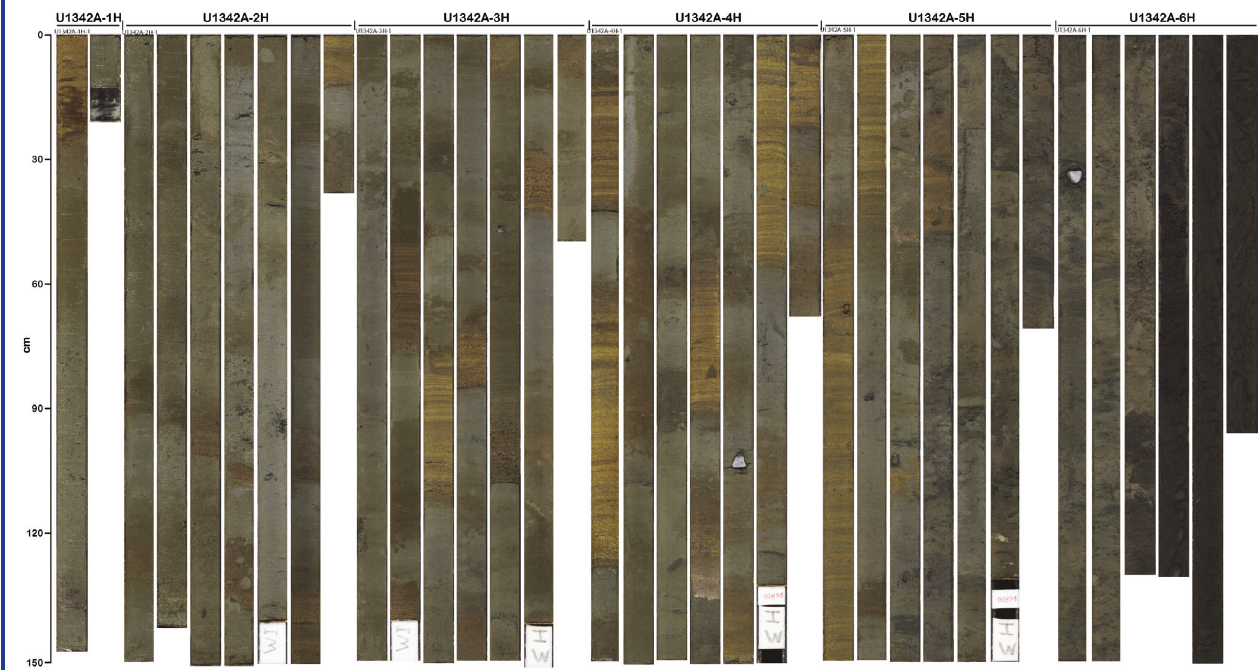
Figure 5. Photographs of Cores 323-U1342A-1H through 6H, bulk of sediments above the underlain volcanic basement rocks, showing ubiquitous occurrences of laminated sediments with horizontally banded features. Site U1342 is located at shallow water depth of 819 m, within today’s OMZ (see Fig.